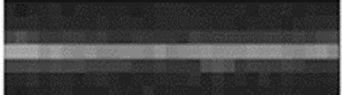
Figure 16. Line target in an image.